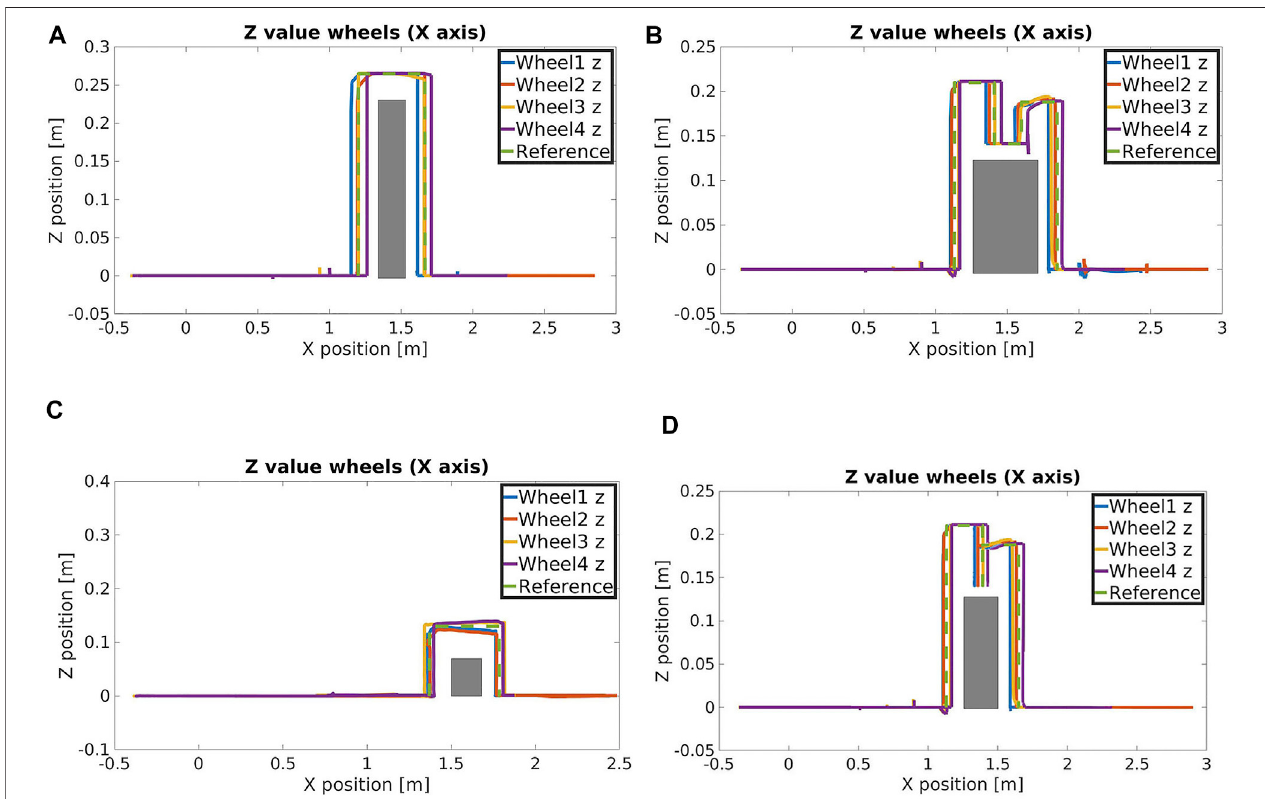
FIGURE 14 | Z position of the wheels during (A) stepping over, (B) stepping on, (C) stepping over 7 cm height obstacle and (D) crossing a small obstacle without stepping over primitive.